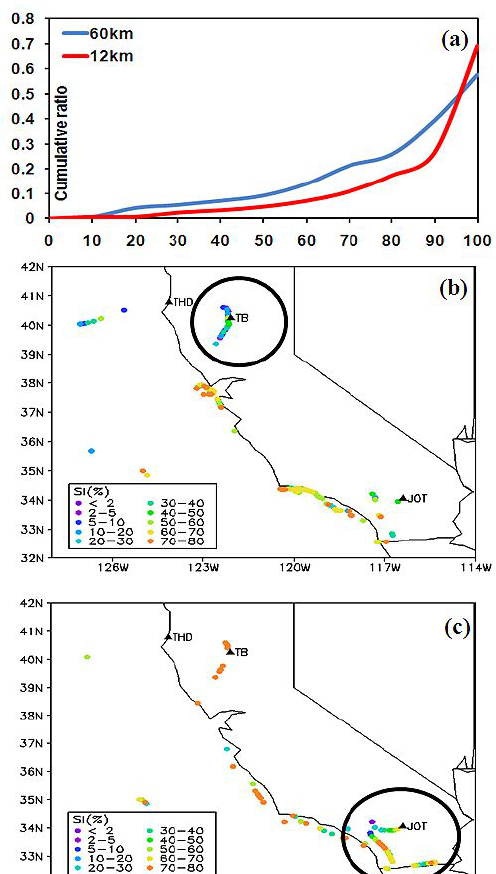
Fig. 18. (a) Cumulative ratios for 60km and 12km cases; Data points below 80% SI in (b) 60km and (c) 12km cases along the 22 and 24 June flight tracks below